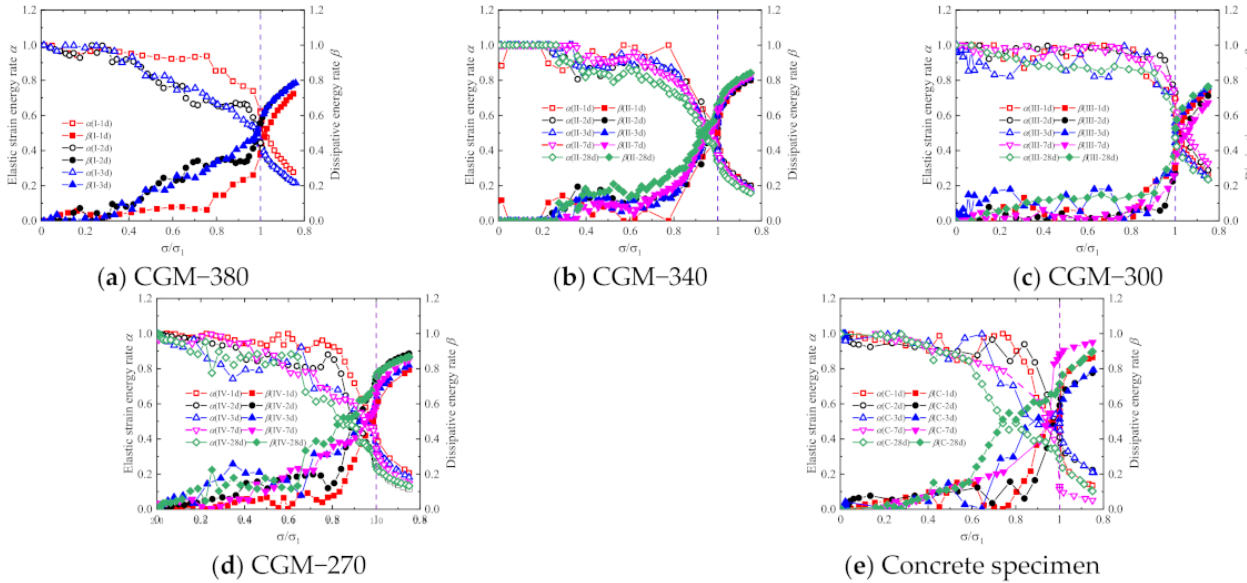
Figure 14. Variations of energy evolution of ( a ) CGM − 380; ( b ) CGM − 340; ( c ) CGM − 300; ( d ) CGM − 270; and ( e ) concrete